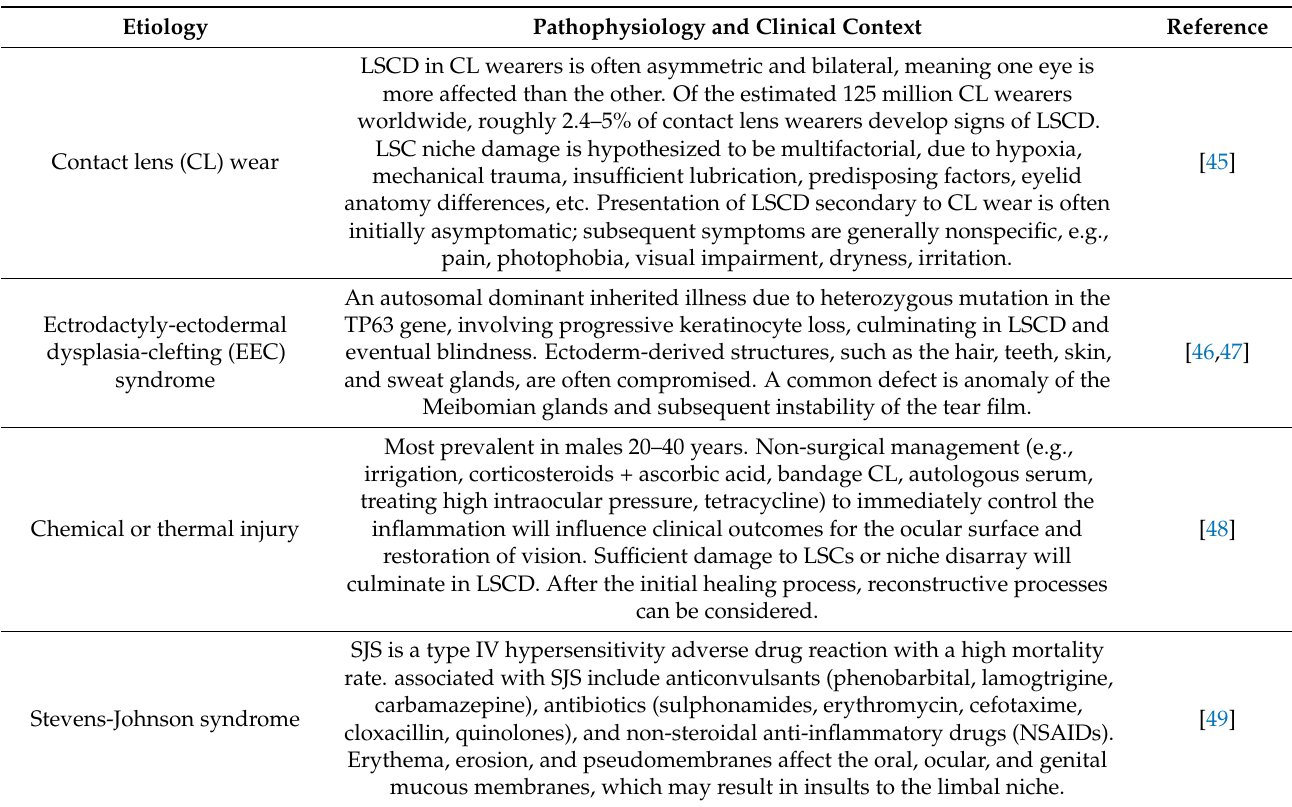
Table 2. Major etiologies of